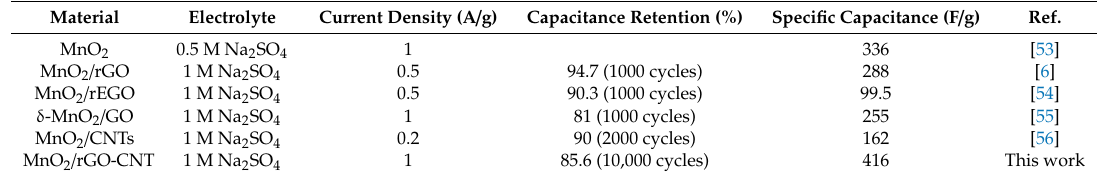
rEGO: reduced graphene oxide obtained from electrochemical exfoliation